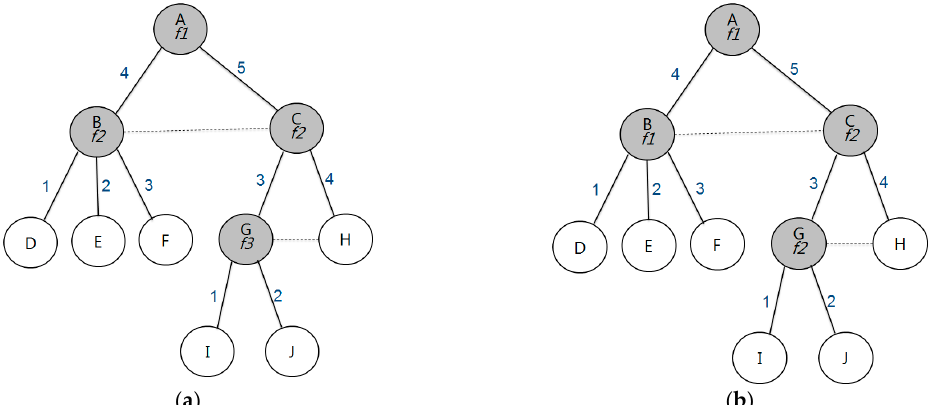
Figure 1. Comparing the channel optimization in the same tree: ( a ) using three channels; and ( b ) using two channels.